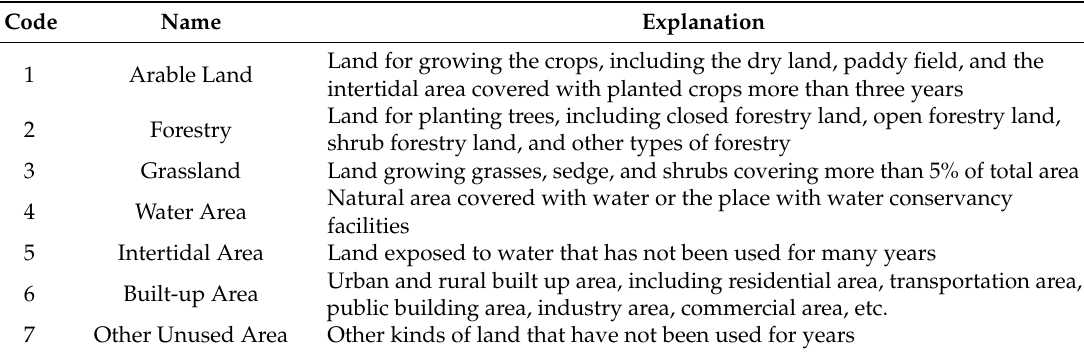
Table 1. The classification system of land use types of Jiangsu province.